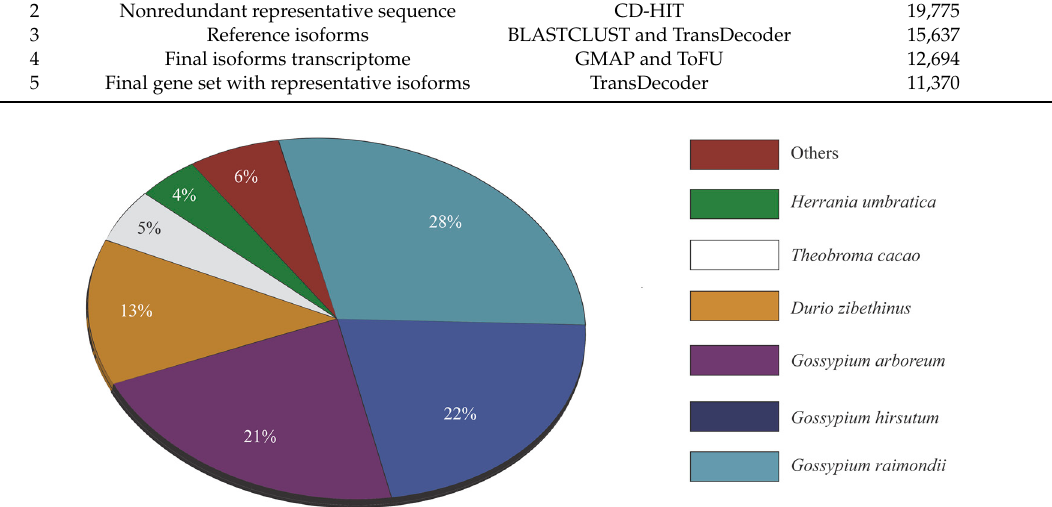
Figure 1. Distribution of top-hit species in BLASTx searches of kenaf unigenes against the NCBI nr and UniProt databases. Table 1. Summary of platforms used establishing gene set in kenaf.